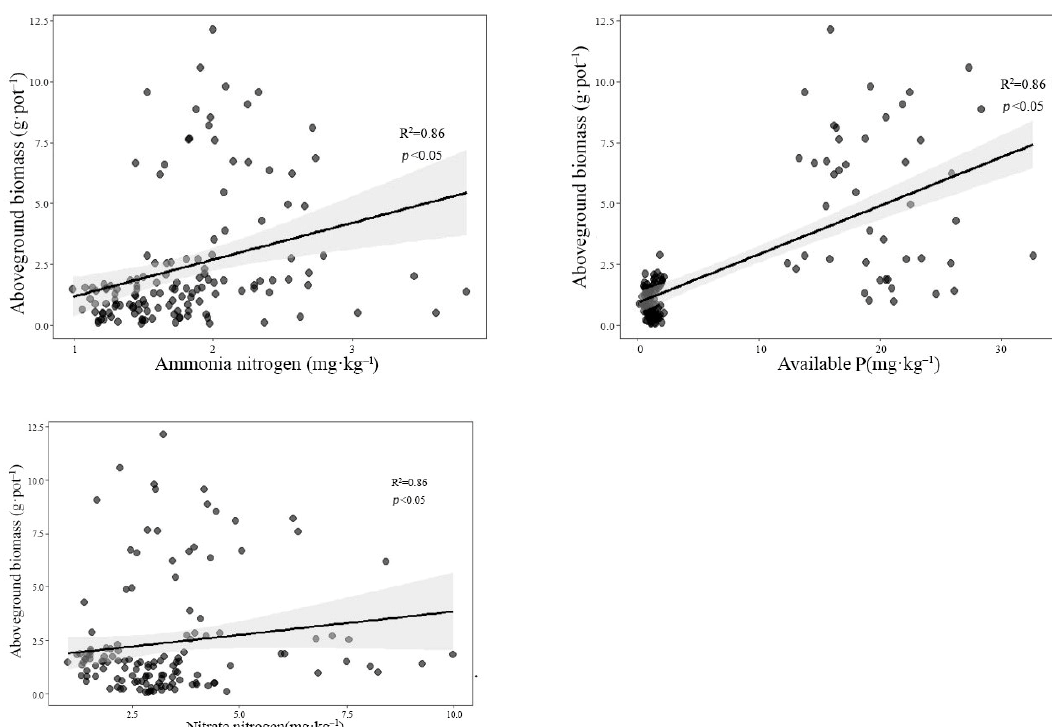
Figure 10. Relationships between available P, NH 4+ -N, and NO — -N contents in soil and plant community productivity.